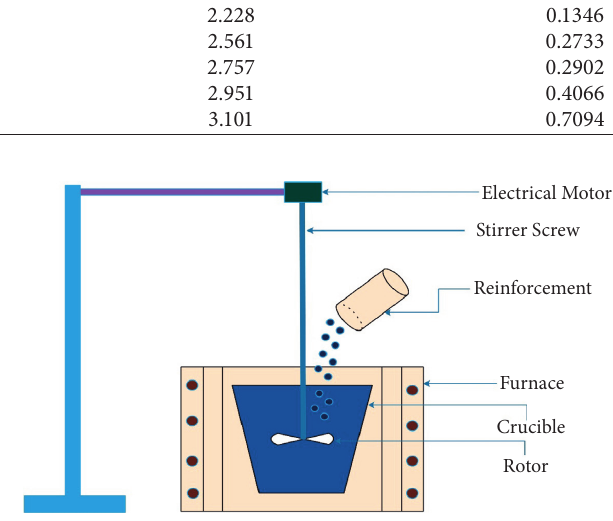
Figure 1: Experimental setup of the stir-casting